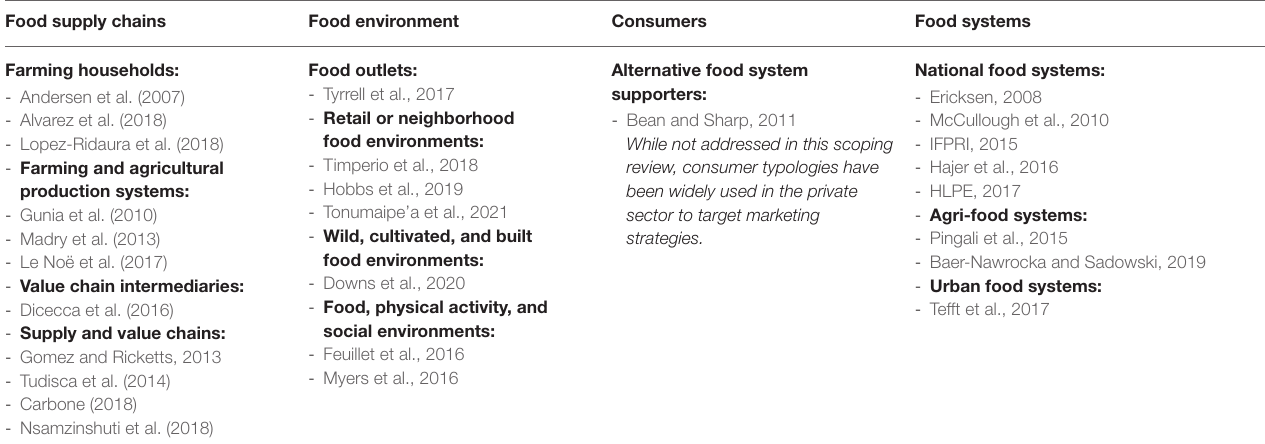
TABLE 1 | Illustrative examples of food systems-related typologies from the literature. Food supply